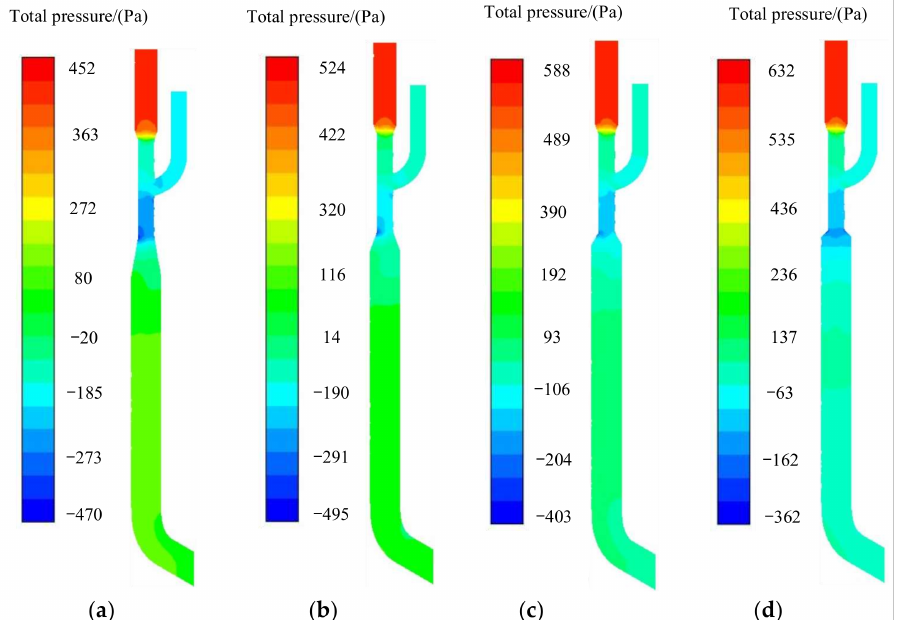
Figure 11. Airflow-pressure contours of different diffusion angles. ( a ) γ 2 = 10 ◦ , ( b ) γ 2 = 20 ◦ , ( c ) γ 2 = 30 ◦ , ( d ) γ 2 = 40 ◦ .